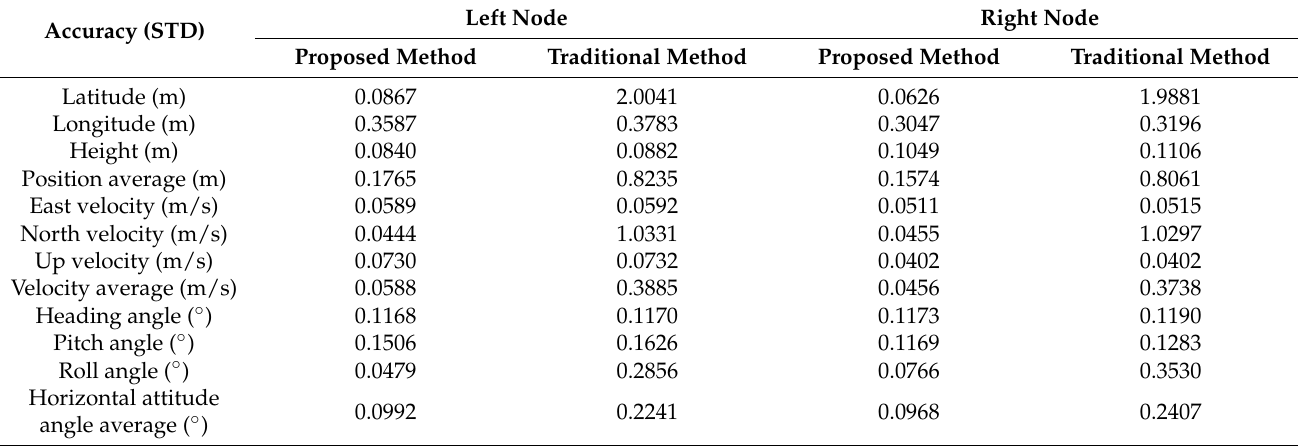
Table 4. STD accuracy of position, velocity and attitude.